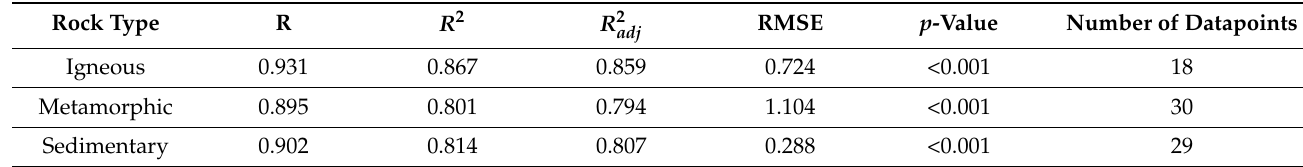
Table 6. Results of soil depth prediction models at the verification